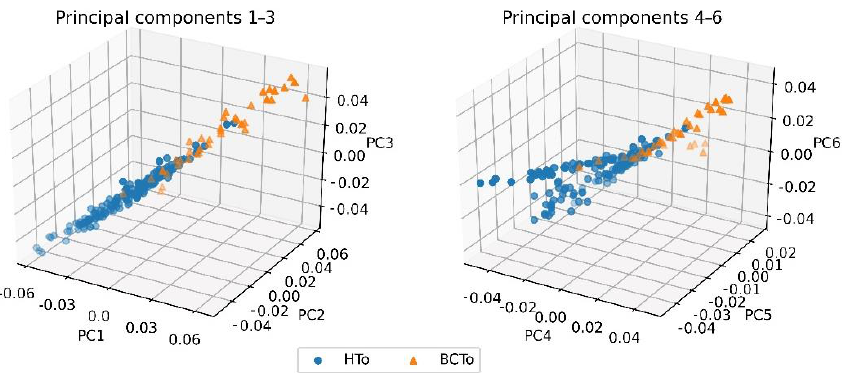
Figure 2. Class separability between HTo and BCTo sets across principal component spaces PC1–PC3 and PC4–PC6.